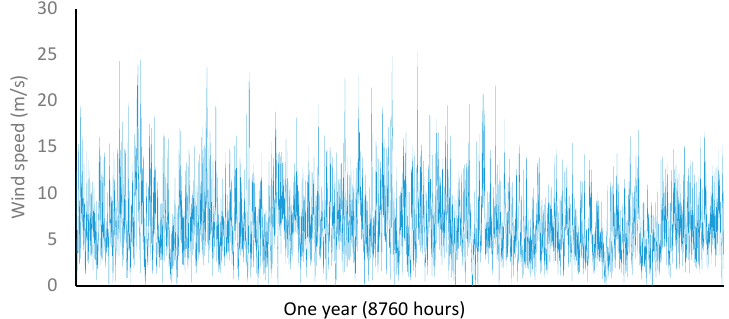
Figure 2. Wind speed (in an average year) at the microgrid location.